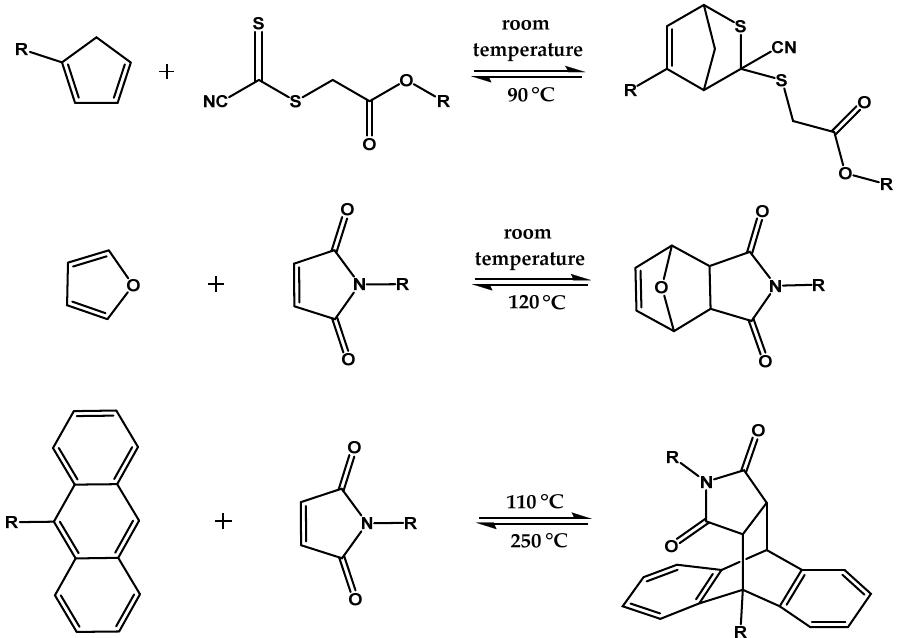
Figure 2. Various Diels-Alder motifs that can be incorporated into a polymer, with their respective products and the corresponding temperatures for the Diels-Alder and retro-Diels-Alder reaction.